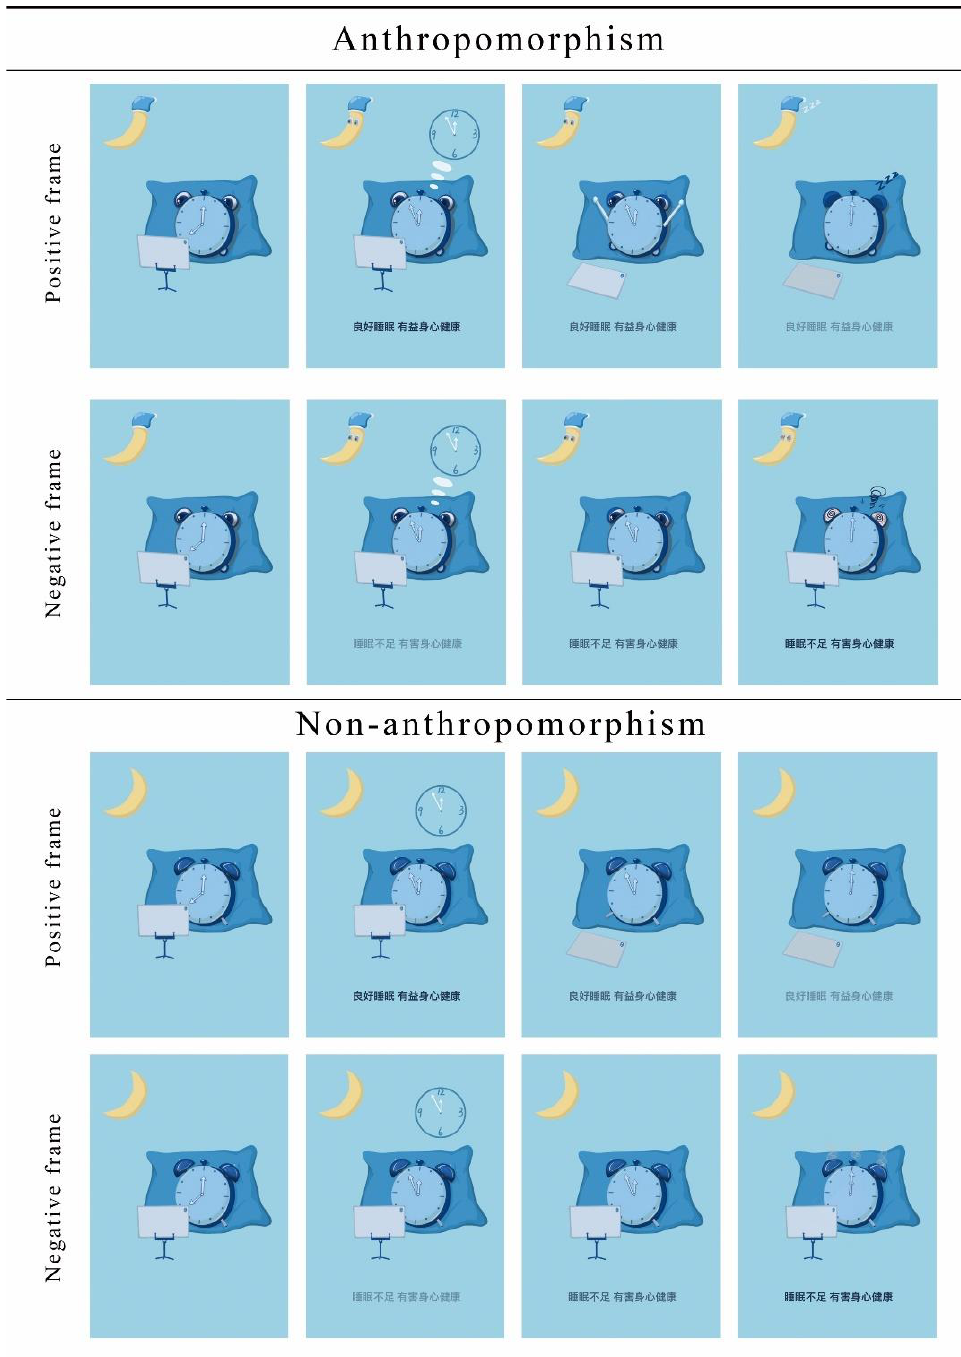
Figure A1. The experimental material. 睡眠不足 有害身心健康 : Lack of sleep is harmful to physi- cal and mental health. 良好睡眠 有益身心健康 : Good sleep is good for physical and mental health.